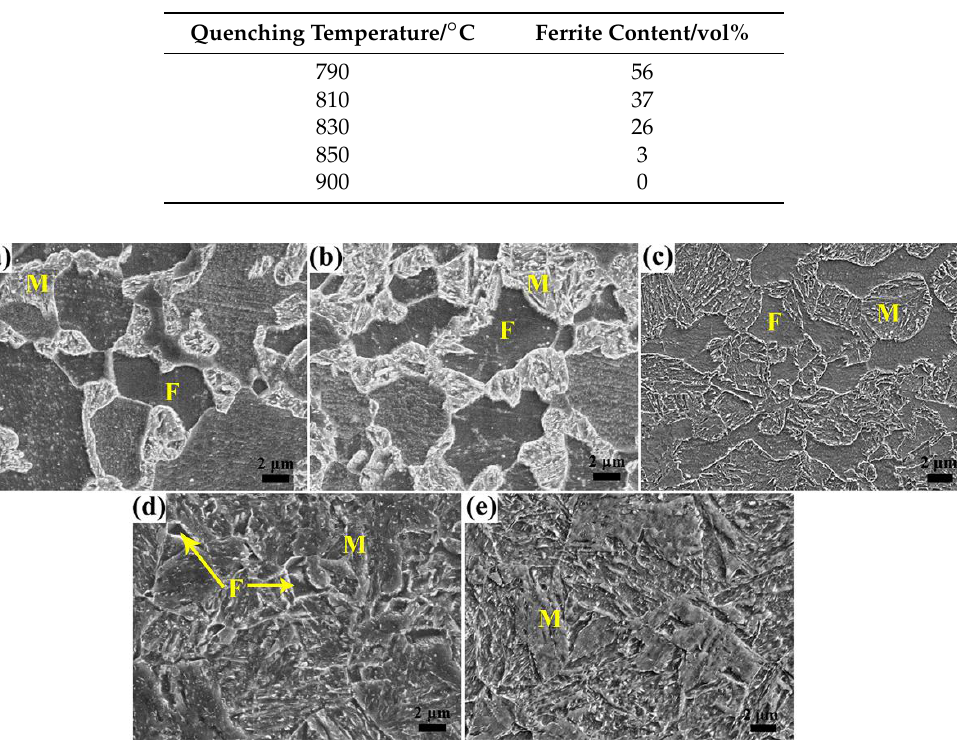
Figure 2. SEM microstructure of HSLA steel quenched from ( a ) 790 °C, ( b ) 810 °C, ( c ) 830 °C, ( d ) 850 °C, and ( e ) 900 °C, and tempered at 450